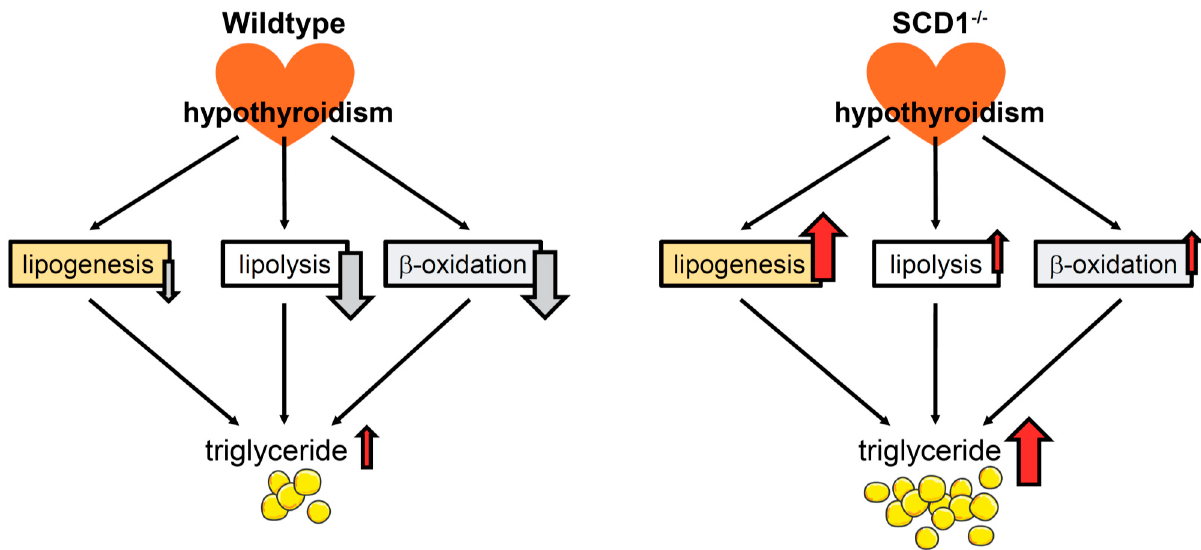
Figure 7. Hypothyroidism leads to the accumulation of lipids in the heart in SCD1 − / − and wildtype (WT) mice by regulating different pathways. In WT hypothyroid mice, lipogenesis decreased, but lipid catabolism was also strongly downregulated, which leads to steatosis in cardiomyocytes. In contrast, in SCD1 − / − hypothyroid mice, cardiac steatosis is caused by an increase in lipogenesis, despite an upregulation of lipolysis and fatty acid oxidation.